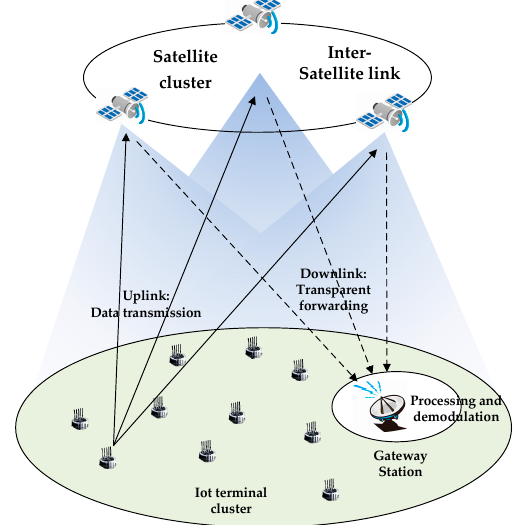
Figure 1. An IoT scenario